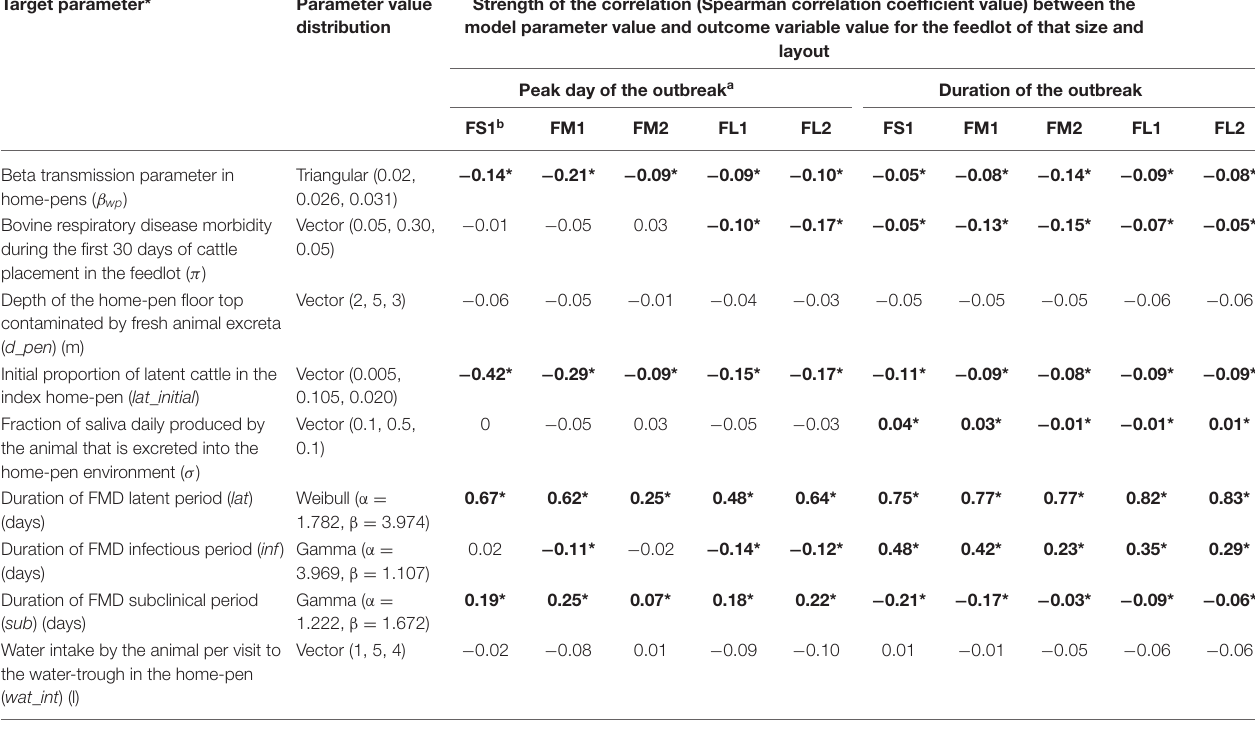
TABLE 4 | Target parameters investigated for associations with the projected outbreak’s peak day with highest number of clinical cattle since foot-and-mouth disease introduction and the total outbreak duration on a U.S. beef cattle feedlot. Target parameter*